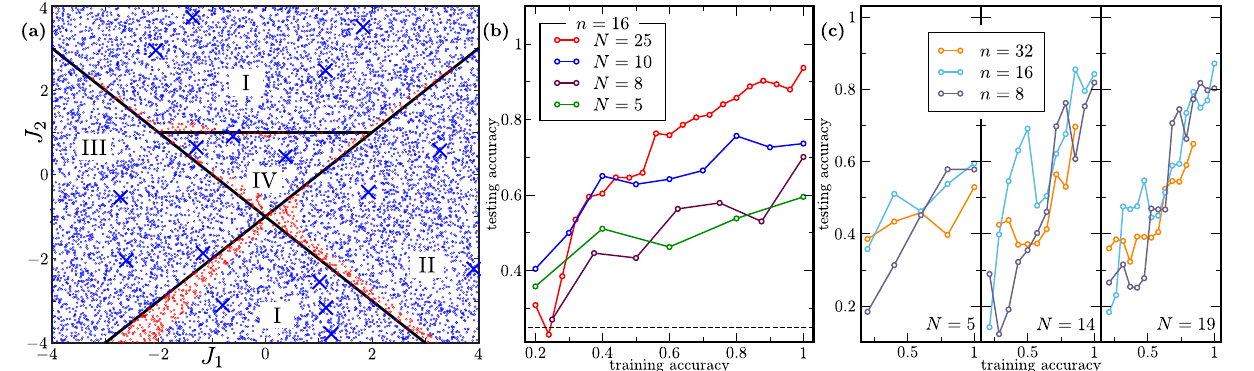
Fig. 2 | Generalization performance of quantum phase recognition. We employedtheQCNNarchitectureforquantumphaserecognitionongroundstates of the generalized cluster Hamiltonian H of Eq. (9). We evaluated the phase assigned by the QCNN to a point in the J 1 - J 2 -plane by sampling 8192 computational basis measurement outcomes and taking the least frequent outcome as the pre- dicted phase. Panel ( a ) visualizes the performance of the QCNN for 16-qubits, trained with 30 data points, which were labelled according to the analytically determinedphase diagram.Bluecrossesdenotetraining datapoints(notall30are shown). Blue (red) circles represent correctly (incorrectly) classi fi ed points. Panel